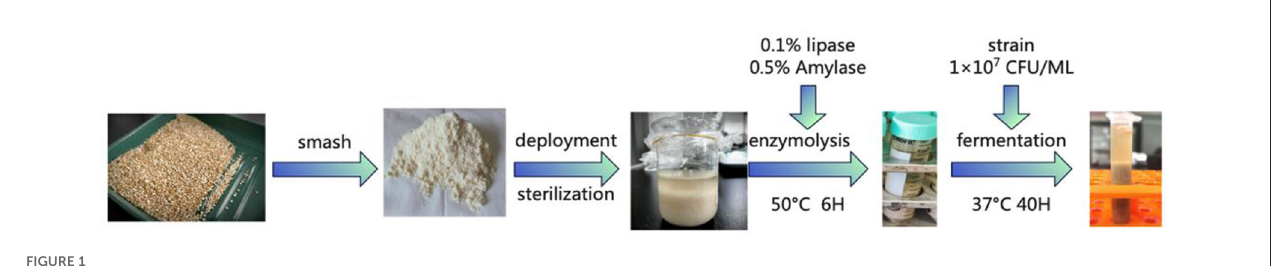
FIGURE1 Flow diagram of quinoa peptide